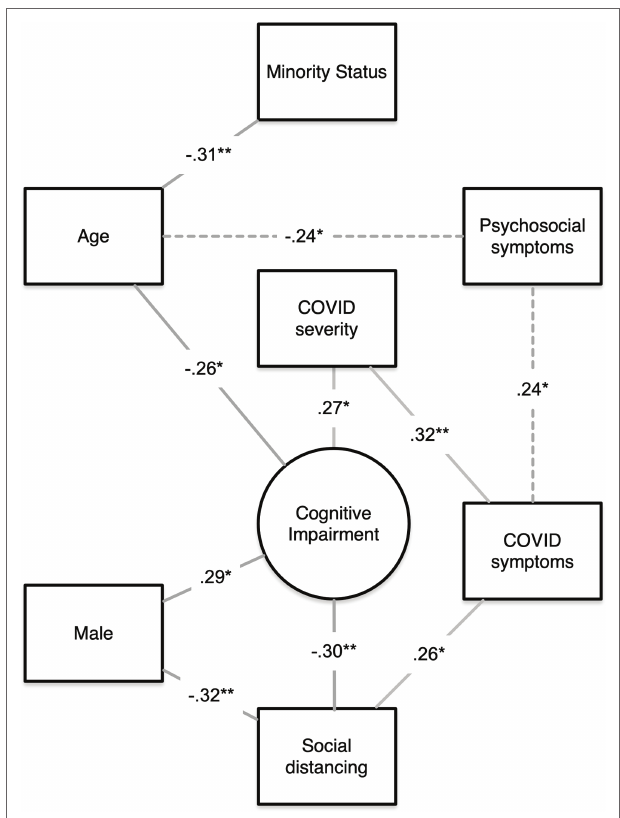
FIGURE 1 | Summary of contributors to objective cognitive impairment. A visual summary of our findings showing the significant correlations among age, psychosocial symptoms, minority status, sex, number of COVID symptoms, COVID severity, social distancing, and objective cognitive impairment. Lines indicate that a significant correlation was noted between the two variables. Lines are labeled with the correlation coefficient, and the asterisk indicates the significance level (* p < 0.05, ** p < 0.01). Paths representing multiple correlations (dashed lines) are labeled with the minimum correlation coefficient only. Chi-square data for sex effects are expressed as correlation coefficients for